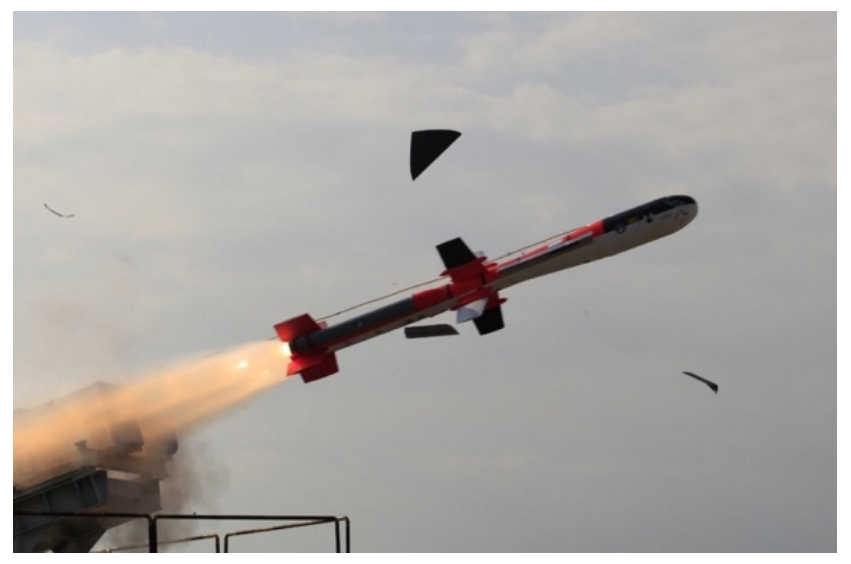
Figure 4. Marte ER missile ejection.